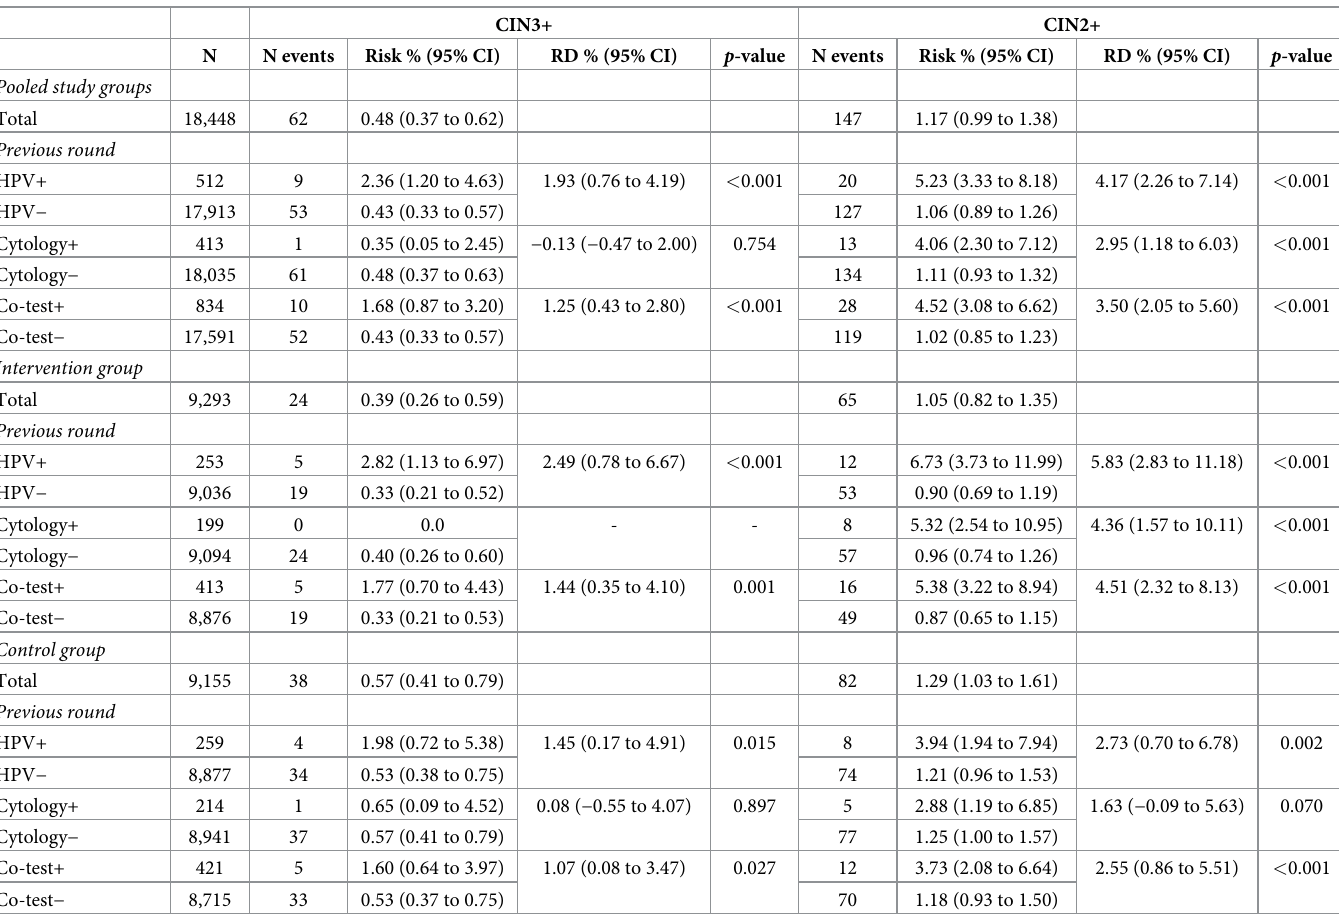
Table 2. Absolute risks of CIN3+ and CIN2+ and risk differences at 14-year among HPV–negative women stratified for previous test result and study